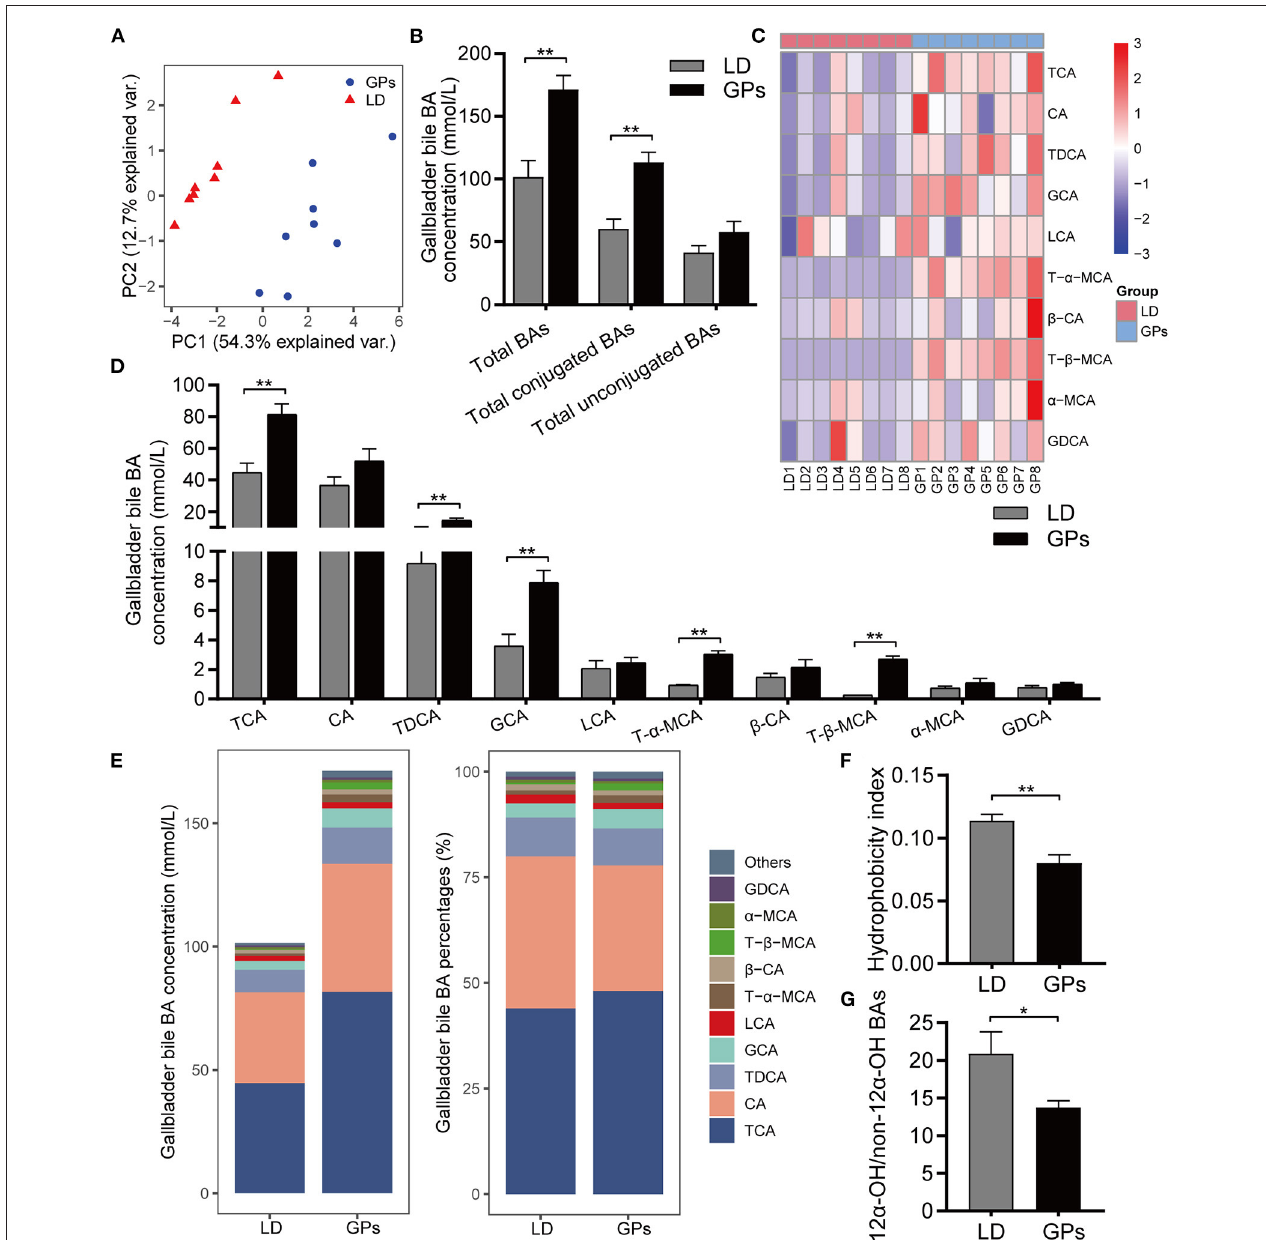
FIGURE 3 | The bile acid (BA) composition of gallbladder bile. (A) Principal component analysis (PCA) of gallbladder bile. (B) Total BAs, conjugated BAs and unconjugated BAs in bile. (C) Heatmap of the top-10 most abundant BA species. (D) Concentrations of BAs. (E) Average concentration (left) and percentage (right) of individual BA species in each group. (F) Hydrophobicity Index of BAs. (G) Ratio of 12 α -hydroxylated (12 α -OH) BAs to non-12 α -OH BAs. Data are reported as means ± SEM ( n = 8). * P < 0.05, ** P < 0.01.